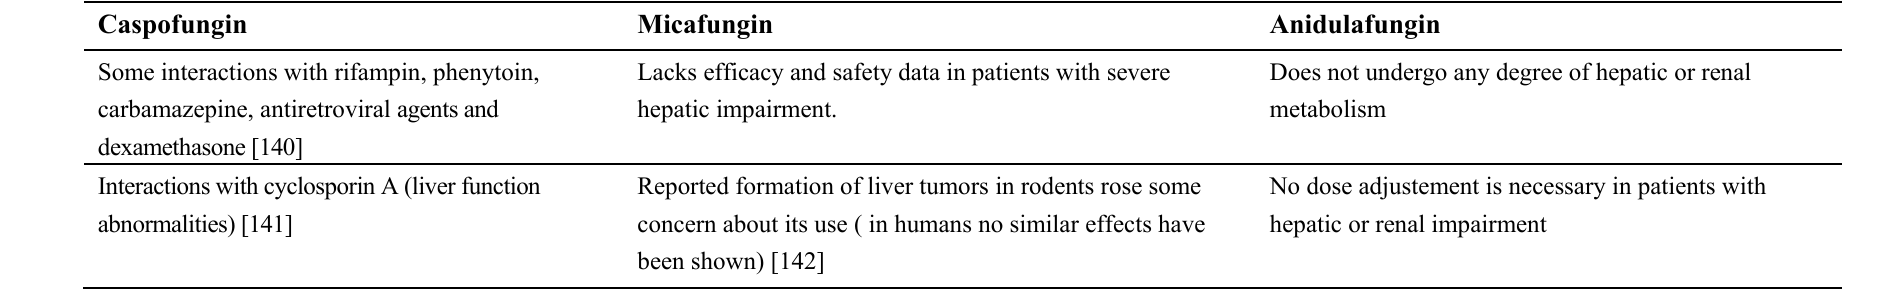
Table 5. Differences on side effects and drug-drug interactions of echinocandins.